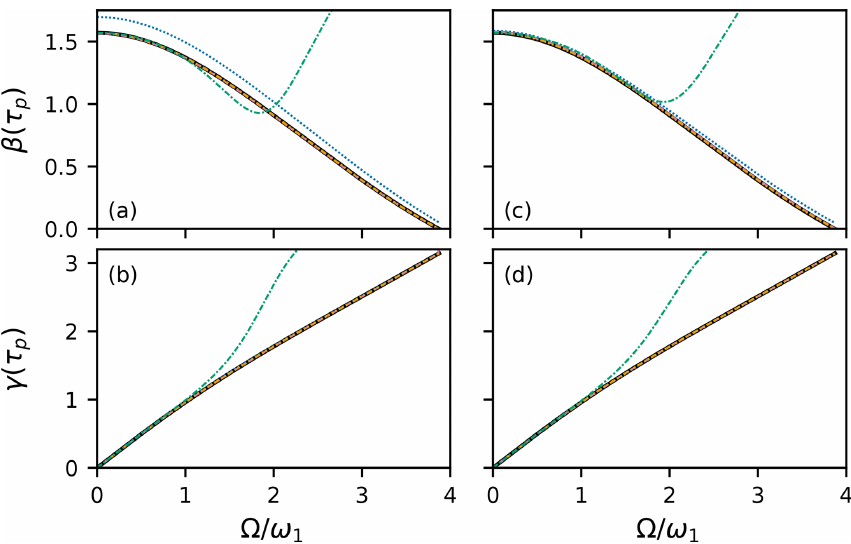
Figure 1. HAM approximations for on-resonance 90 ◦ rectangular pulse with ω 1 / (2 π ) = 25000Hz. Exact calculation of Euler angles β ( τ p ) and γ ( τ p ) (black line). For a rectangular pulse, α ( τ p ) = γ ( τ p ). First-order (blue dotted line), second-order (reddish-purple dashed line), and third-order (orange dash–dot–dotted line) HAM results using method 1. The third-order result is found using the power series of method 2 (green dash-dotted line). Results are shown for (a, b) c 0 = − 1 and (c, d) c 0 = − 0 . 925. The exact, second-order HAM and third-order HAM curves for method 1 are virtually